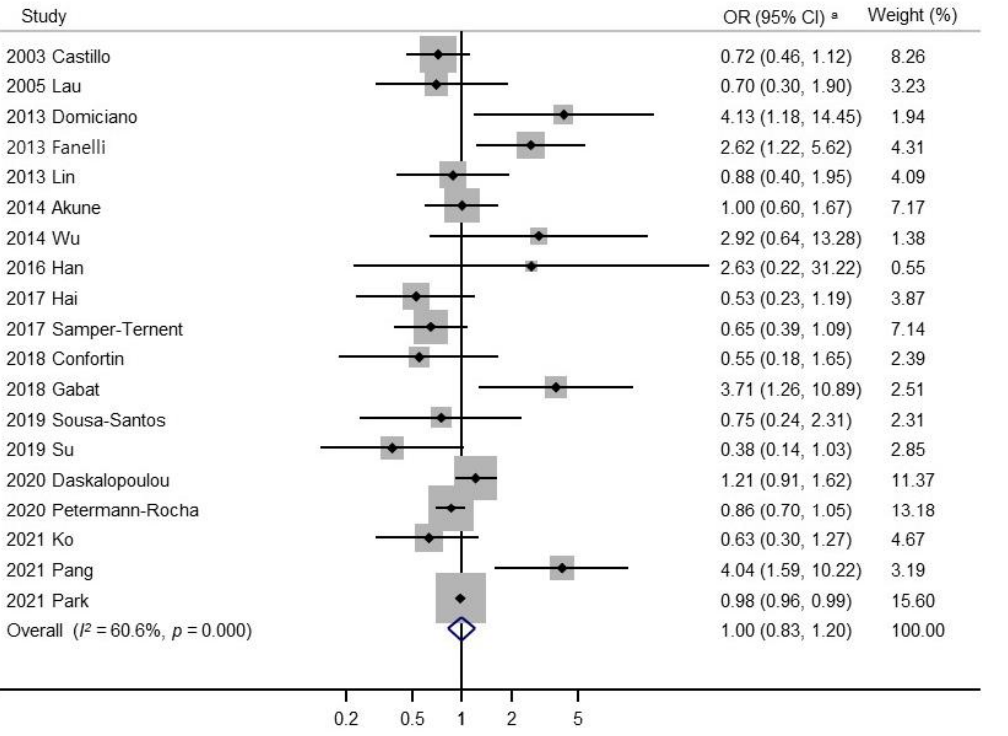
Figure 2. Meta-analysis of the association between sarcopenia and alcohol consumption of observational studies ( n = 19). a Random Effects Model. Abbreviations: OR, odds ratio; CI, confidence interval [15–21,27,28,30–38].